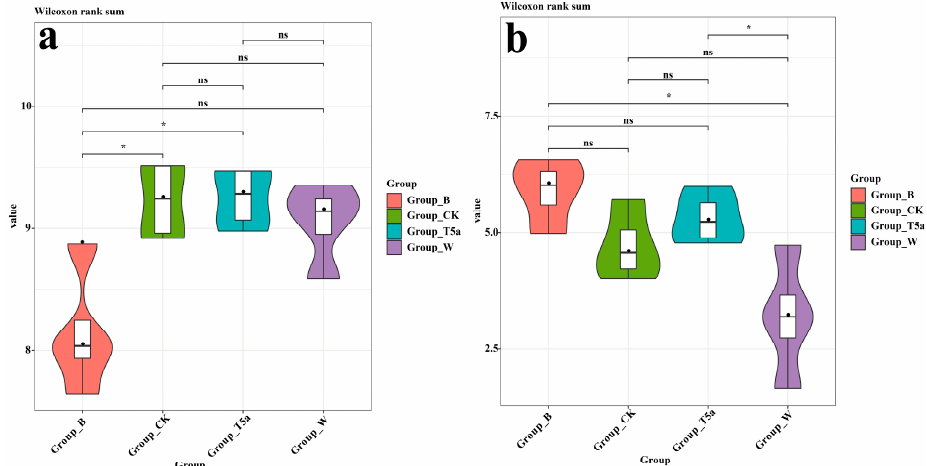
Figure 5. Alpha diversity of soil bacterial ( a ) and fungal ( b ) communities in the casing soil of different treatments of G. leucocontextum cultivation. * indicates significant differences between treatments at p < 0.05. ns indicates there is no significant difference between different treatments.